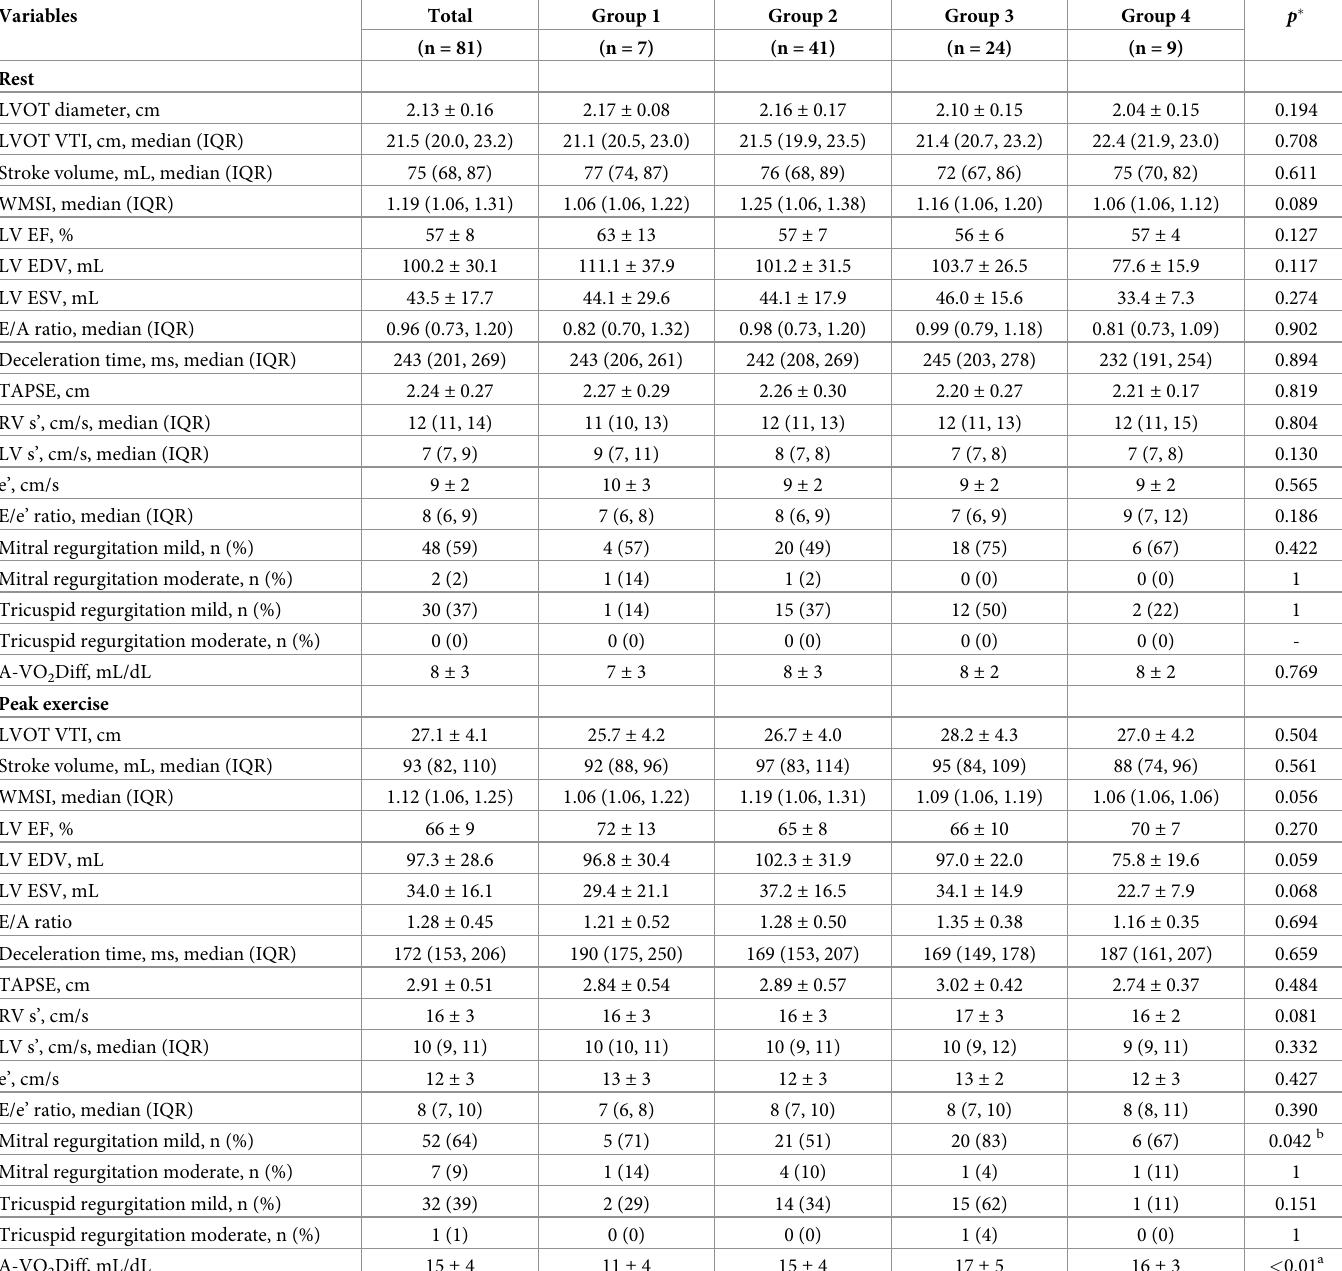
Table 3. Stress echocardiography parameters during combined exercise testing according to percentage of predicted oxygen uptake (Group 1, < 50%; Group 2, 50– 74%; Group 3, 75–99%; and Group 4, �